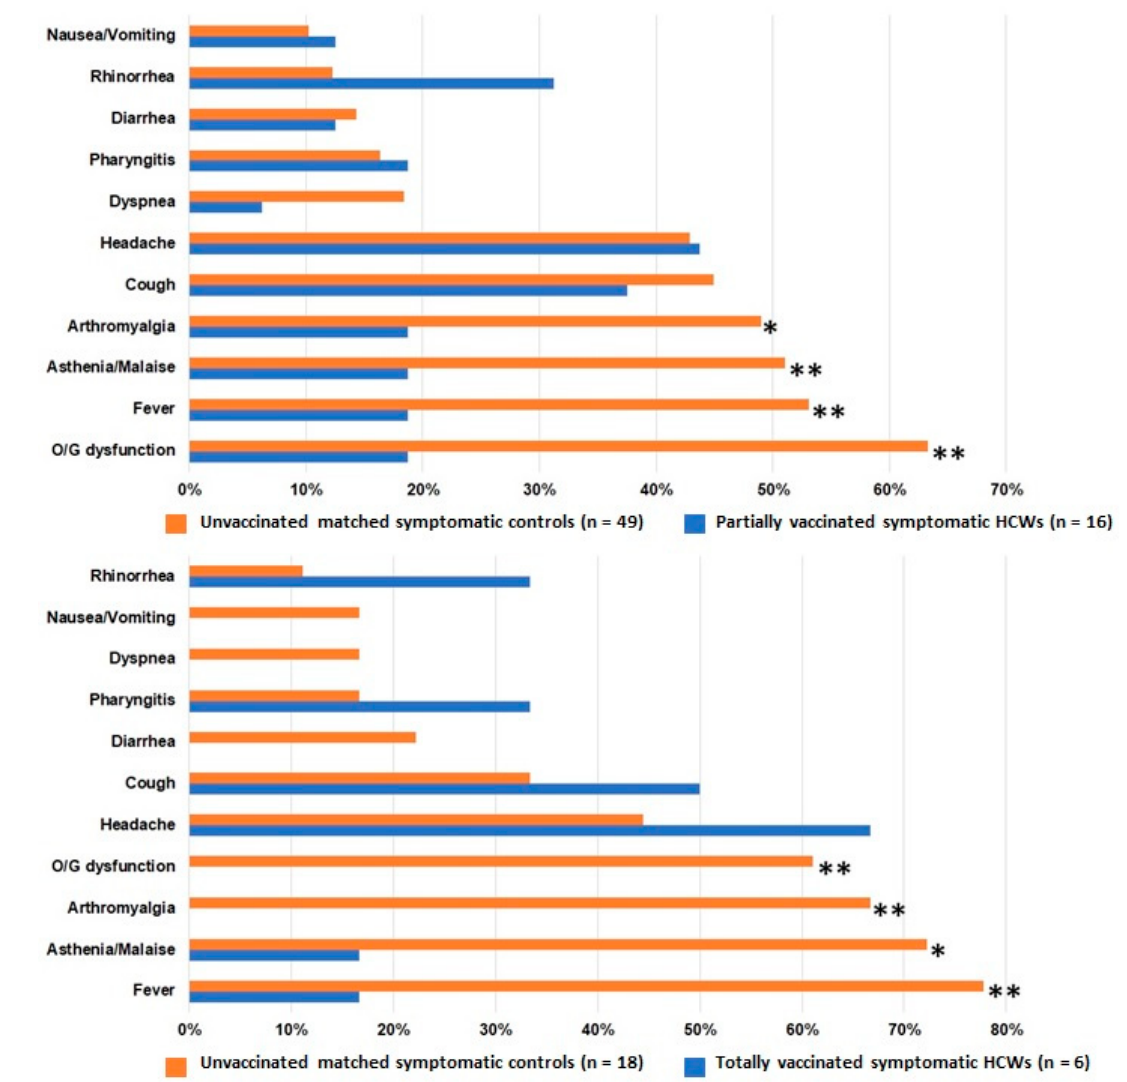
Figure 1. Comparison of COVID-19-related signs and symptoms between partially and totally vaccinated symptomatic 1 health care workers and corresponding unvaccinated age- and sex-matched controls. ** p value < 0.05; * trend for statistical significance. Legend: HCWs, health care workers; O/G dysfunction, olfactory and/or gustatory